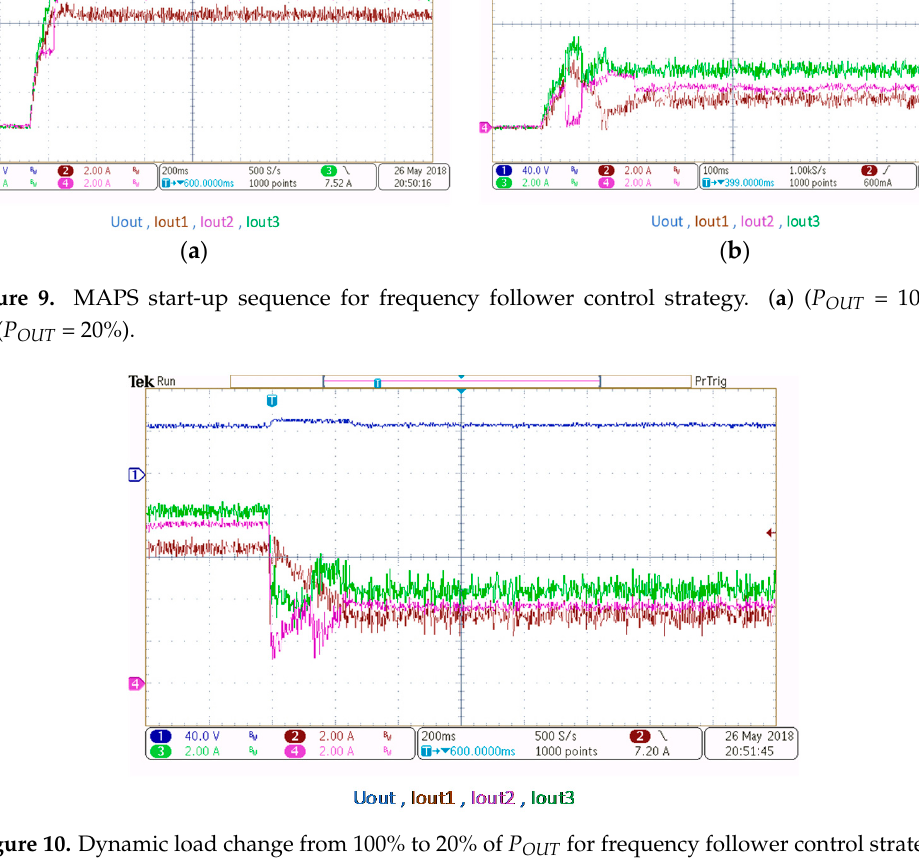
Figure 9. MAPS start-up sequence for frequency follower control strategy. ( a ) ( P OUT = 100%), ( b ) ( P OUT = 20%) .